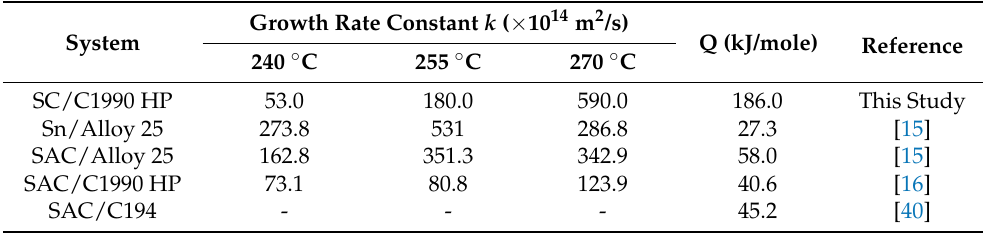
Figure 12. The Arrhenius plots of the growth rate constant of the Cu 6 Sn 5 phase (ln k) vs. 1000/T in the SC/C1990 HP. Table 5. Growth rate constant ( k ) and activation energy ( Q ) of the IMC for the SC/C194, SC/Alloy 25, and SC/C1990HP couples reacted at various